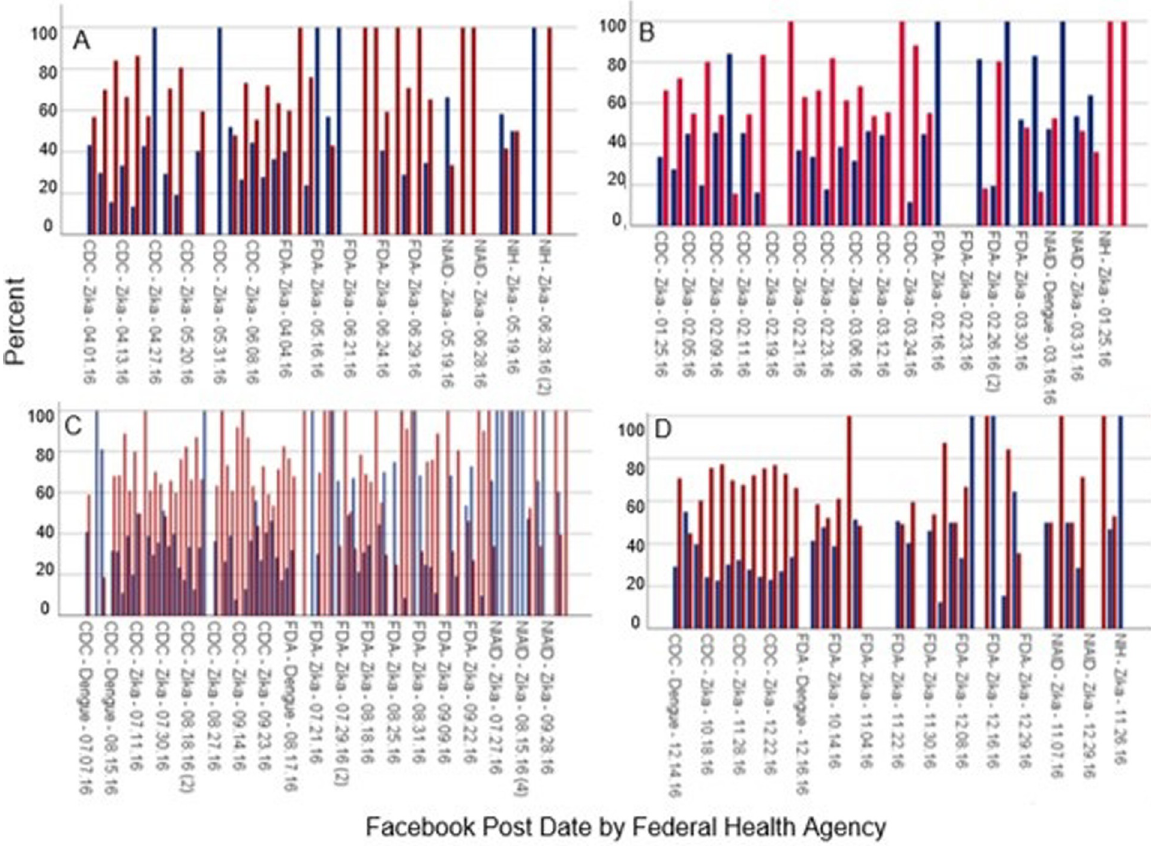
Fig 3. Percentage of sentiment based on coding from A) Quarter 1; January-March 2016, B) Quarter 2; April-June 2016, C) Quarter 3; July- September 2016, D) Quarter 4; October-December 2016. The date on the x-axis represents the date of a post in first quarter of the year 2016. Abbreviations: Centers for Disease Control and Prevention (CDC); Food and Drug Agency (FDA); National Institutes of Allergy and Infectious Disease (NIAID); National Institutes of Health (NIH).